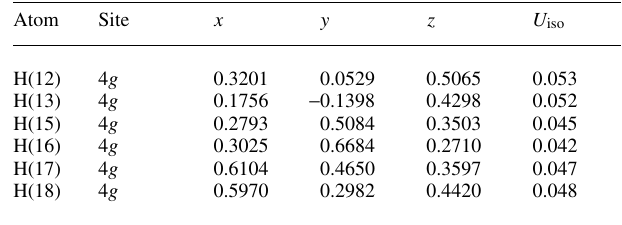
Table 2. Atomic coordinates and displacement parameters (in Å 2 )